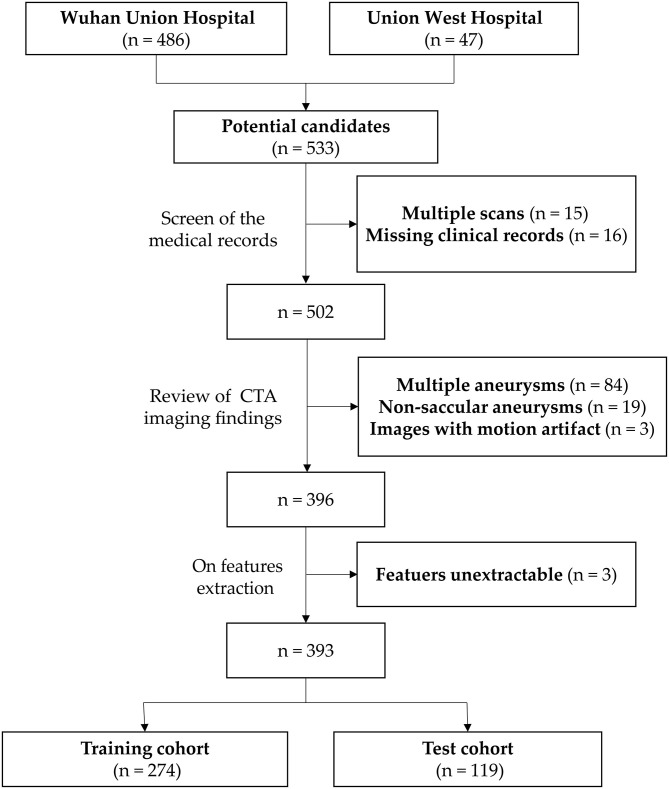
Flowchart of the patients' inclusion and exclusion process.